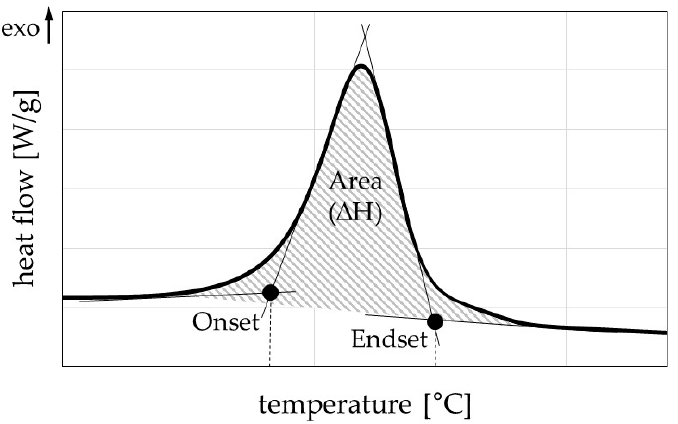
Figure 2. Differential scanning calorimetry (DSC) descriptors: onset, endset and the area under the peak.